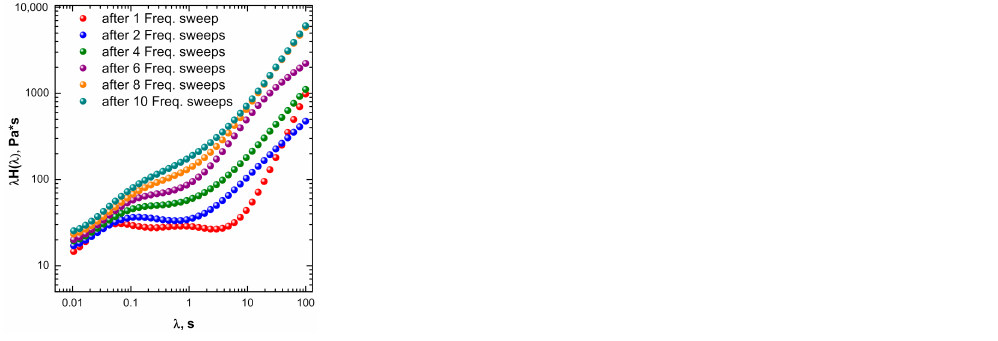
Figure 5. Weighted relaxation spectra for ENR+SiO 2 system subjected to subsequent frequency sweep measurements.